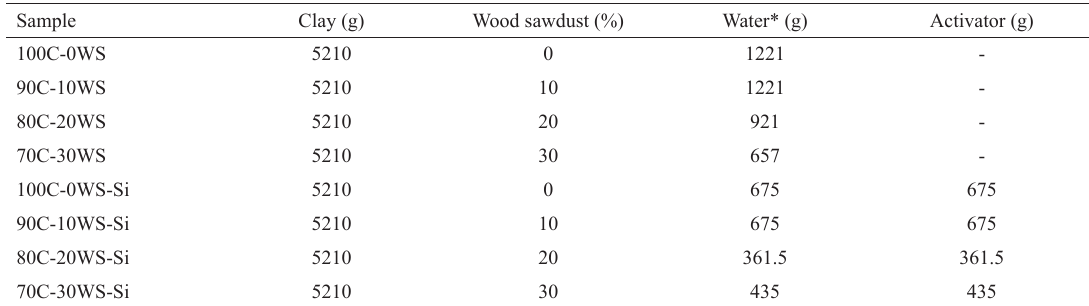
Table 1: Quantity of products used for molding the calcined clay samples.